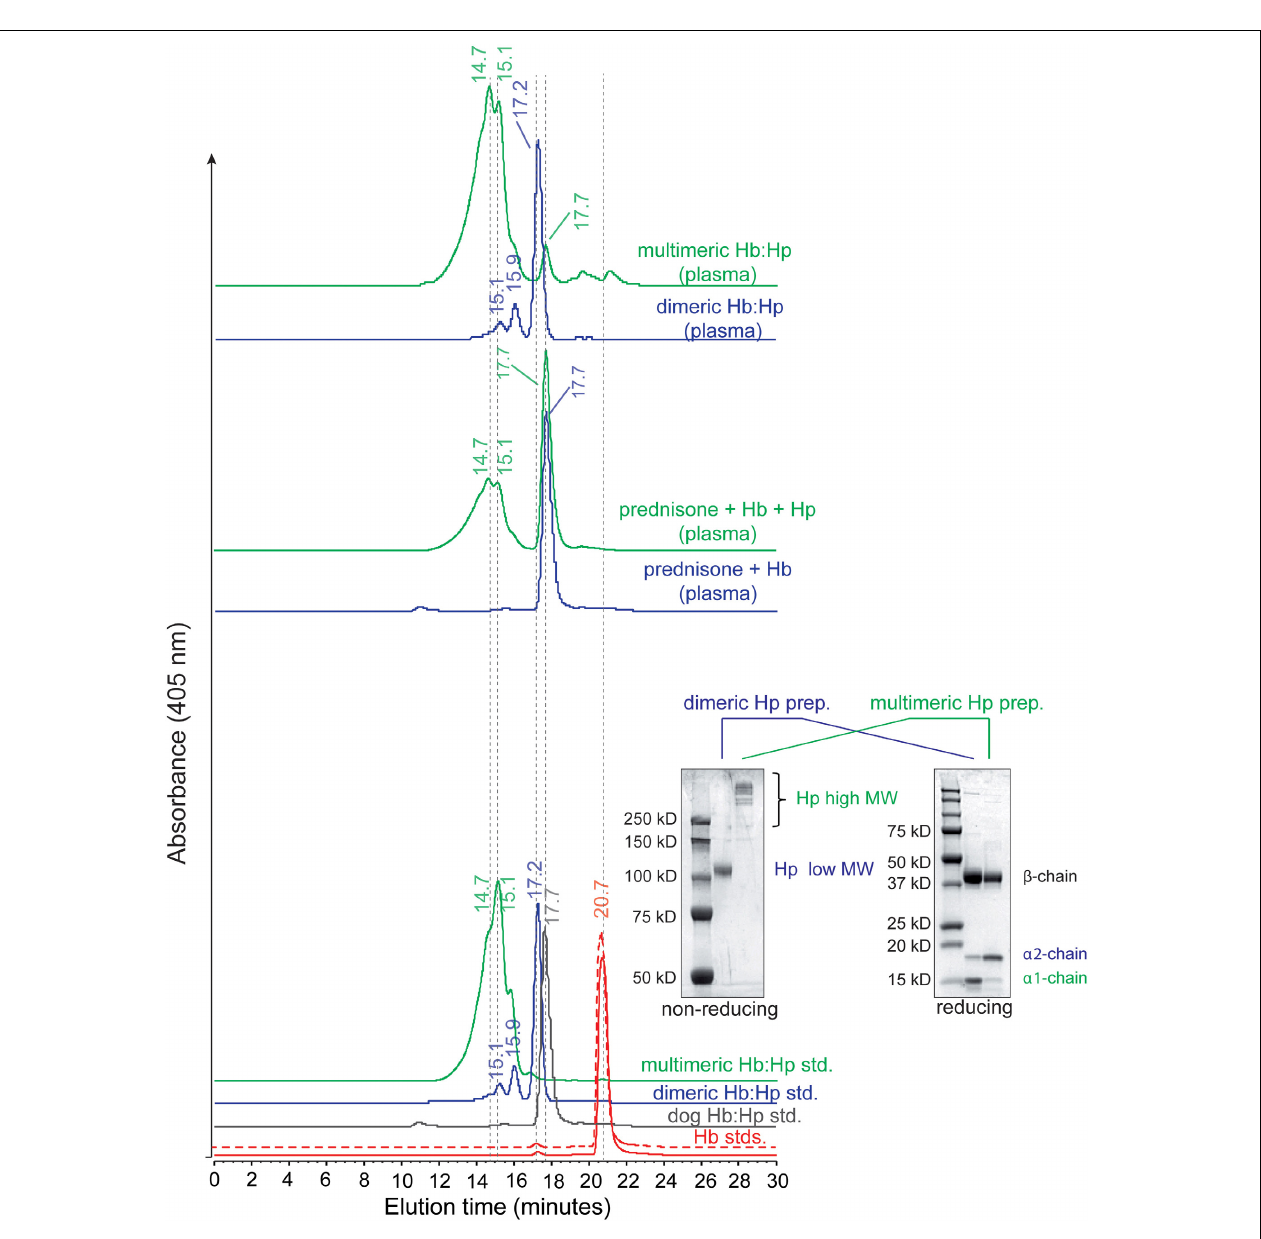
FIGURE 5 | Plasma profiles of bound Hb:Hp complexes. (Bottom panel) SEC elution profiles of standard human Hb (solid red line), dog Hb (dashed red line) and Hb:Hp complexes. Bottom panel inset shows gel electrophoresis of dimeric and multimeric Hp preparations under